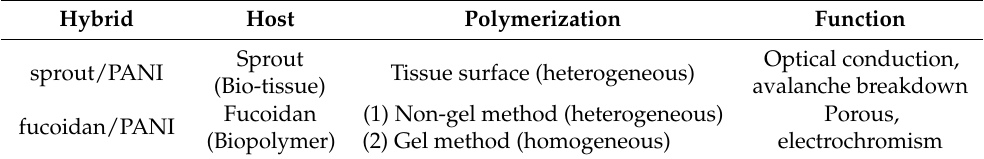
Table 3. Summary of sprout/PANI and fucoidan/PANI. Hybrid Host Polymerization Function Sprout sprout/PANI Tissue surface (heterogeneous) (Bio-tissue)